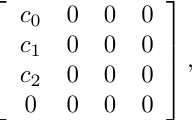
Table 5: S 8 of SKINNY-128 . x ∥ y represents the 8-bit input, where x , y ∈ S 8 ( x || y